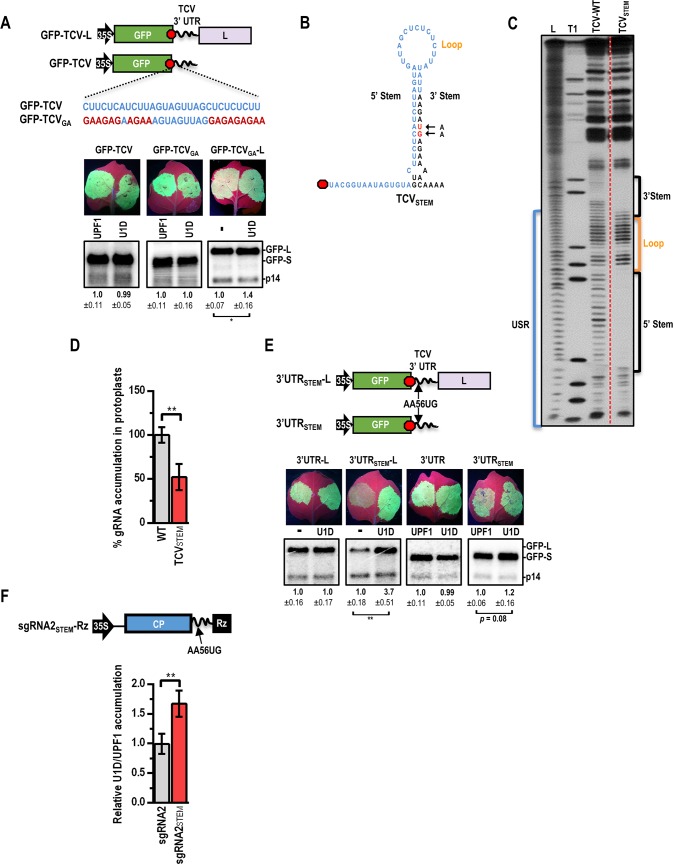
Lack of secondary structure confers NMD-resistance.(A) C/U sequences in two USR segments that were mutated to G/A in GFP-TCVGA and GFP-TCVGA-L are shown. Reporter constructs were agroinfiltrated into N. benthamiana along with constructs expressing p14 and either UPF1, U1D, or mock (-). Results are from three infiltrations and standard deviation is shown. See legend to Fig 2B for more information. (B) Hairpin generated in USR of TCVSTEM is shown. Mutations (in red) were introduced outside of the USR (blue residues) in TCV-WT. (C) In-line probing of TCV-WT and TCVSTEM USR regions. L, hydroxide-generated ladder; T1, partial RNase T1 digest for position of guanylates. Bands denote residue flexibility (unpaired) required to assume in-line geometry necessary for backbone cleavage. Brackets (right side) denote positions of stem loop formed in TCVSTEM. (D) Accumulation of TCV-WT and TCVSTEM transcripts in protoplasts at 40 hpi. gRNA levels were quantified by northern blotting for three independent samples. Error bars denote standard deviation. (E) TCV 3’ UTR bearing the 2-base TCVSTEM mutation was inserted into either GFP-S or GFP-L reporter (3’UTRSTEM or 3’UTRSTEM-L). 3’UTR-L and 3’UTRSTEM-L constructs were agroinfiltrated with constructs expressing p14 and either UPF1, U1D, or mock (-). Data are from three infiltrated leaves. Standard deviation is shown. See legend to Fig 2B for more information. (F) sgRNA2 and sgRNA2STEM were co-expressed with p14 and either UPF1 or U1D. mRNA accumulation was assayed by RT-qPCR at 72 hpi. RT-qPCR data are from 5 leaves in two independent experiments. mRNA levels were normalized to those of p14 and is presented as the fold change in accumulation with U1D vs. UPF1. Unpaired t test: **p<0.01.